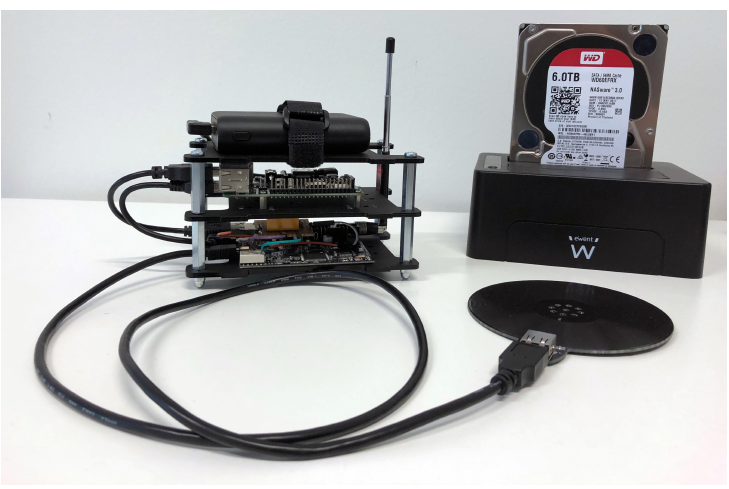
Figure 6: The entire attack platform. Consisting of a Yard Stick one, Proxmark III, Raspberry Pi 3 Model B+, a battery pack and a 6 TB hard